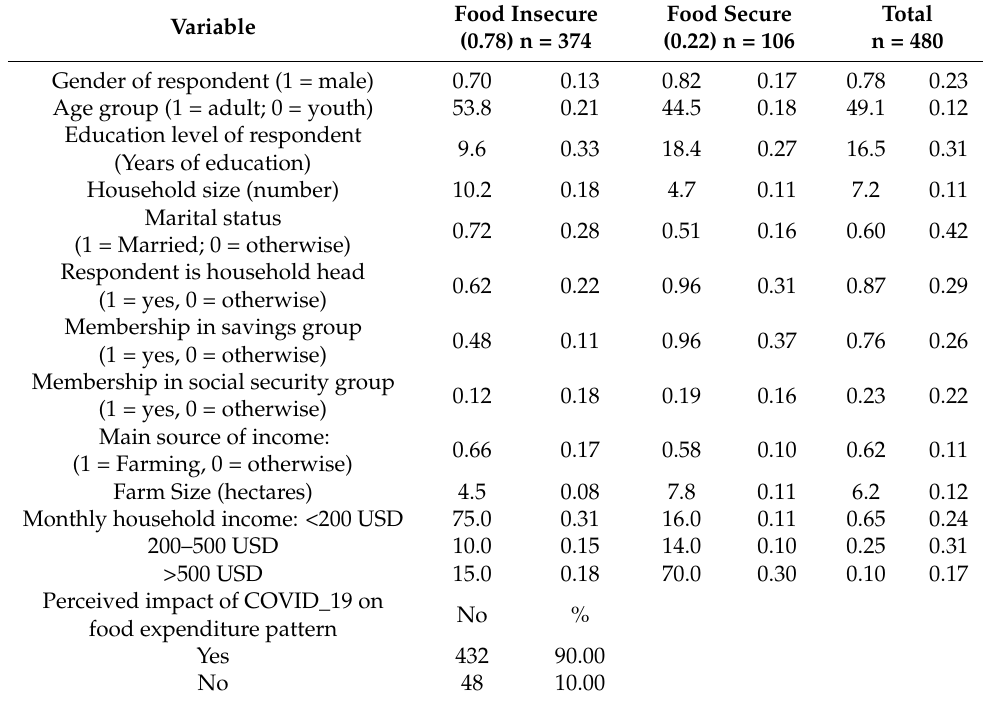
Table 4. Summary statistics of the socio-economic characteristics of respondents (n = 480).